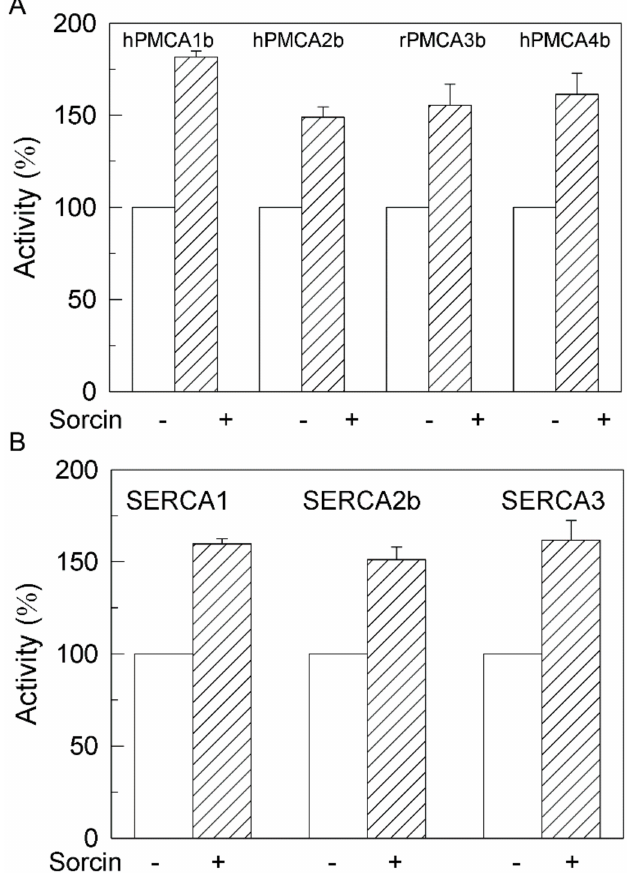
Figure 3. Sorcin activates all PMCA ( A ) and SERCA ( B ) isoforms. Twenty µ g of membranes from COS cells overexpressing PMCA or SERCA isoforms were treated in the absence (plain bars) or presence of 1 µ M sorcin, and 50 µ M CaCl 2 (stripped bars) in 25 µ L, and then diluted up to 1 mL with the assay medium plus 0.01% saponin. Activity was measured as indicated in the Methods Section after addition of 1 mM ATP. The 100% activities correspond to 0.124 ± 0.003, 0.107 ± 0.004, 0.093 ± 0.006 and 0.102 ± 0.01 µ mol.min − 1 .mg − 1 for hPMCA1b, hPMCA2b, rPMCA3b and hPMCA4b respectively, and to 2.57 ± 0.018, 0.086 ± 0.015 and 0.216 ± 0.01 µ mol.min − 1 .mg − 1 for SERCA1, SERCA2b and SERCA3, respectively. Data are mean ± SE of three experiments performed in triplicate with three preparations. p ≤ 0.001 vs.